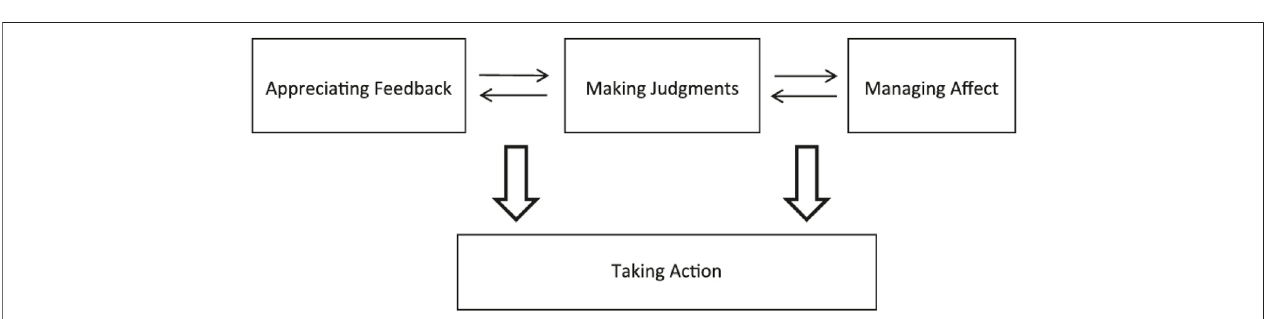
FIGURE 16 | Carless and Boud (2018) Feedback literacy